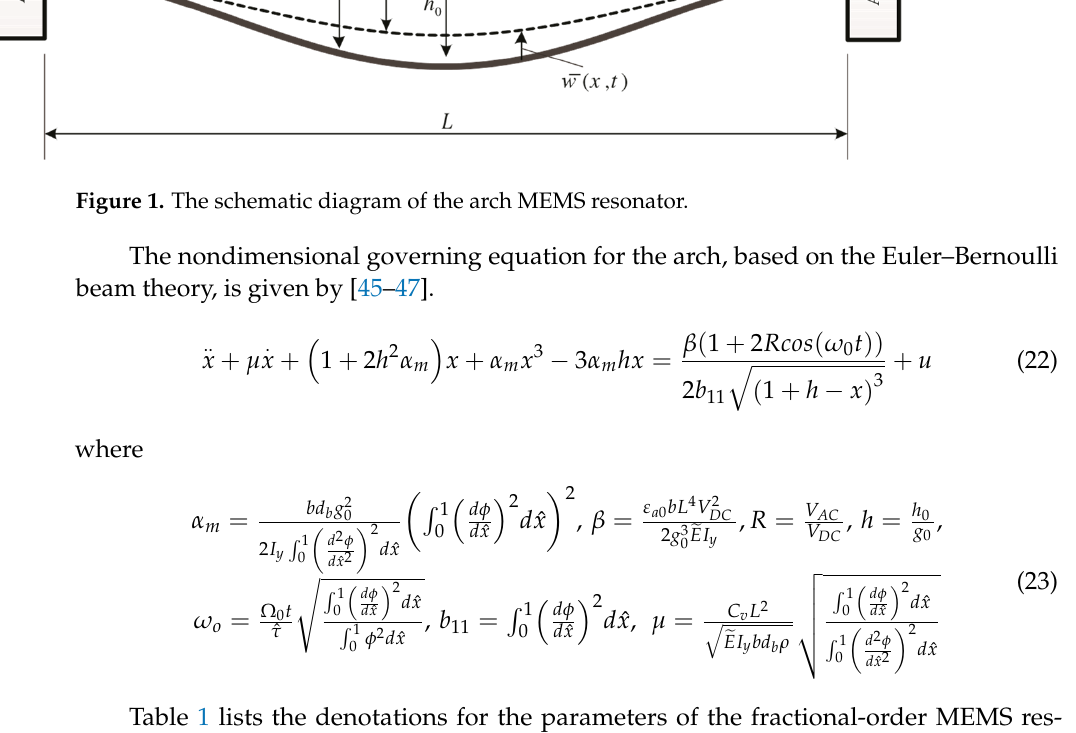
Table 1 lists the denotations for the parameters of the fractional-order MEMS res- onator [5]. Table 1. The parameters of the fractional-order MEMS resonator Table 1. The parameters of the fractional-order MEMS resonator [5].